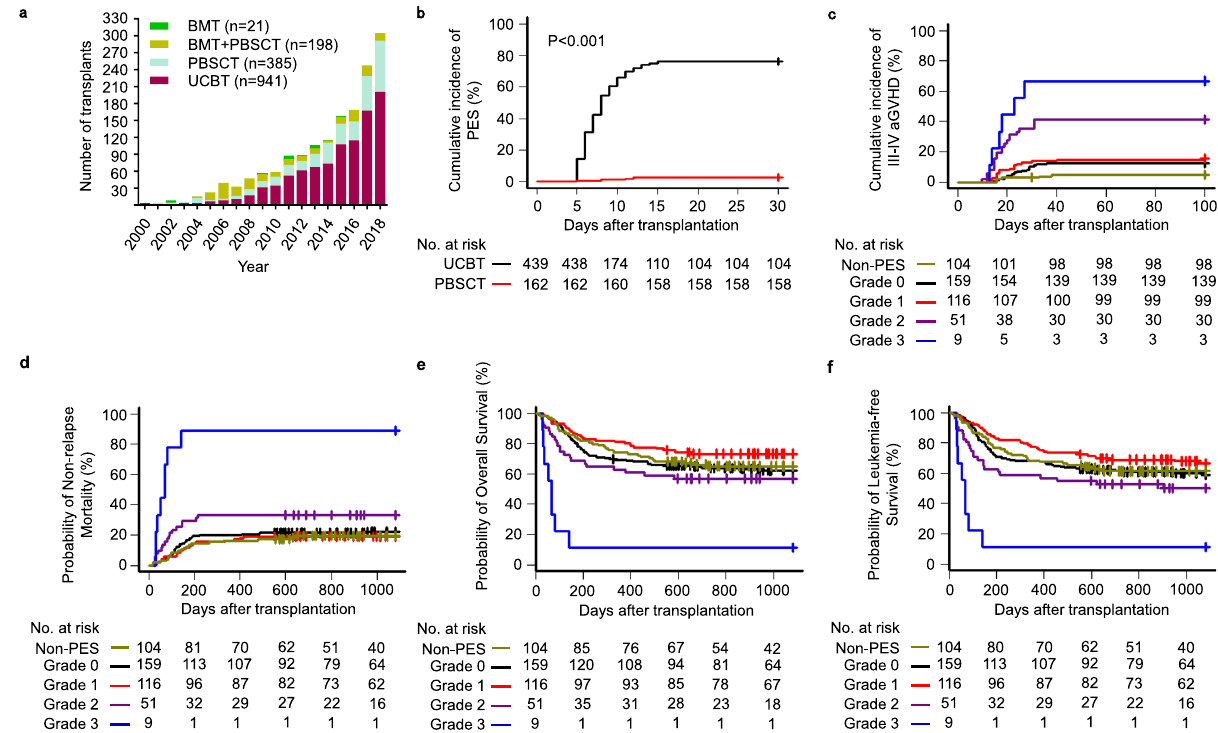
Fig. 1 Outcomes after UCBT or PBSCT in patients with hematopoietic malignancies. a Number of HSCT procedures performed per year. b The cumulative incidence of pre-engraftment syndrome in patients after UCBT or PBSCT. c – f The cumulative incidence of grades III – IV acute graft-versus-host disease at day 100, 3-year nonrelapse mortality, 3-year overall survival, and 3-year disease-free survival of patients with different PES grades: III – IV aGVHD ( c ), nonrelapse mortality ( d ), overall survival ( e ), and leukemia-free survival ( f ). The probabilities of PES, III – IV aGVHD and nonrelapse mortality as summarized by the cumulative incidence of competing events. The probabilities of overall survival and disease-free survival were calculated with Kaplan – Meier curves. Source data are provided as a Source Data fi